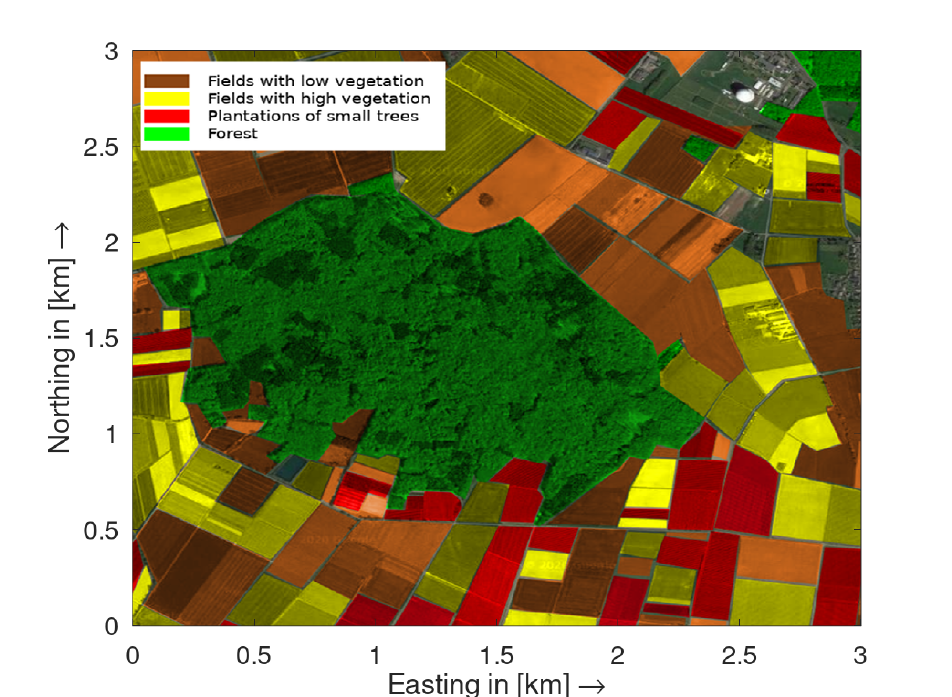
Figure 1. A typical German rural terrain in the Eifel region of western Germany with the colored different terrain groups specified for the bistatic measurements and clutter